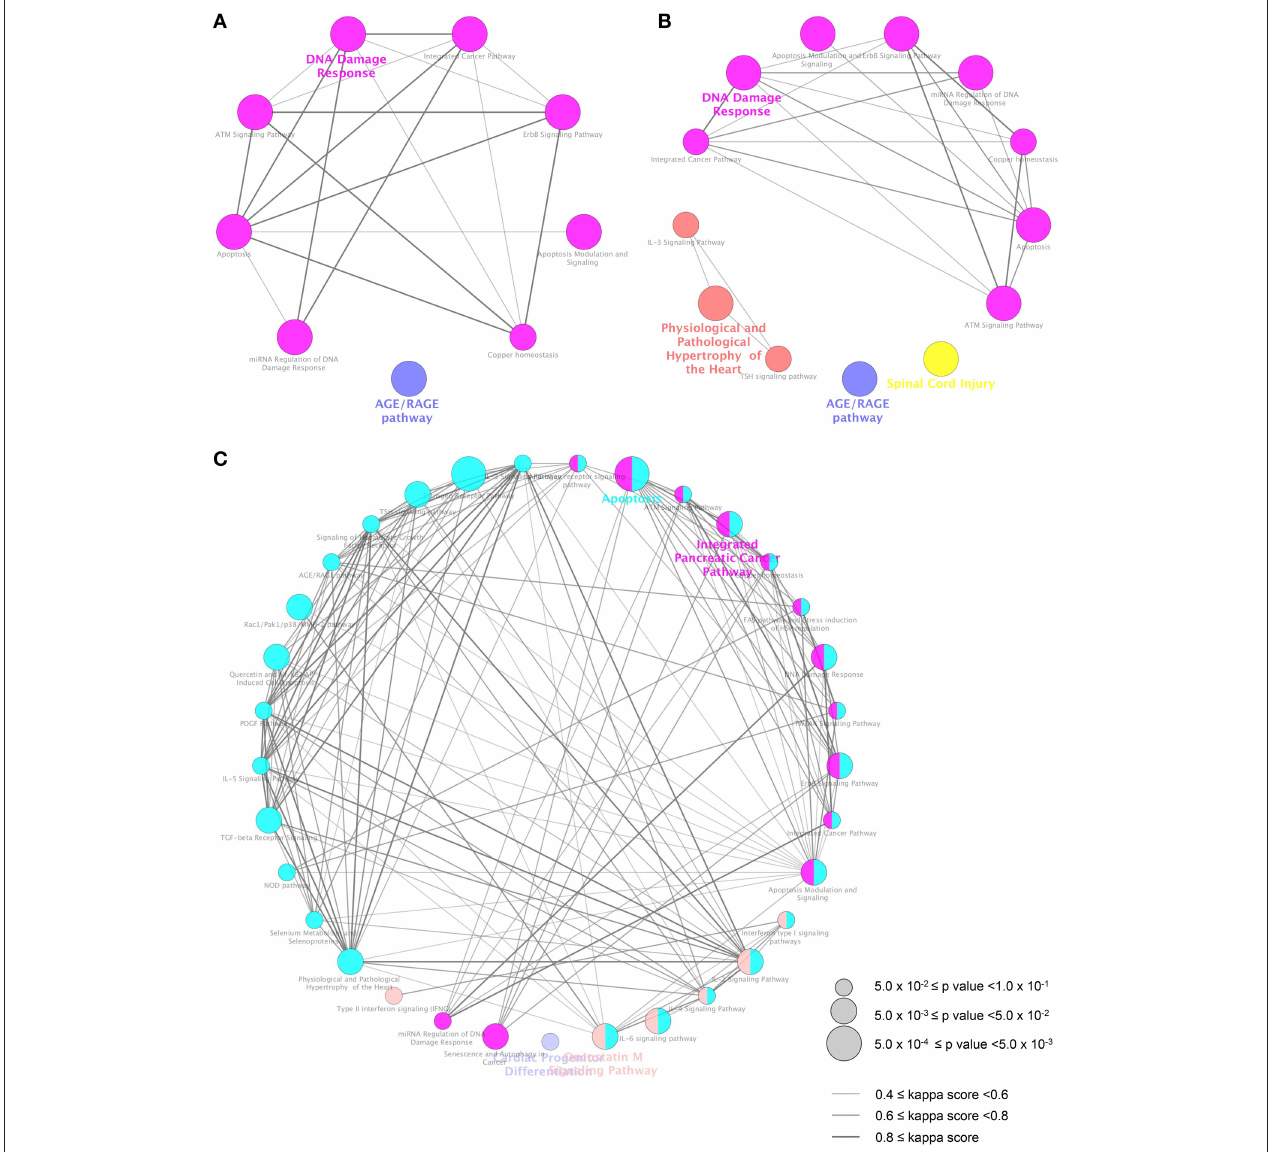
FIGURE 3 | Pathways significantly enriched in the DEGs in zebrafish exposed to MBZ. Genes dysregulated in zebrafish exposed to 0.3 µ M MBZ for 12, 24, and 36h were independently subjected to ClueGO using WikiPathways as the database. The pathways significantly enriched in the DEGs at 12, 24, and 36h exposure are shown in A , B , and C , respectively. Each circle represents one WikiPathway. The size of circle corresponds to the p value for the enrichment. Pairs of WikiPathways with a similar kappa score were connected by lines. WikiPathways clustered in a same group are shown in same